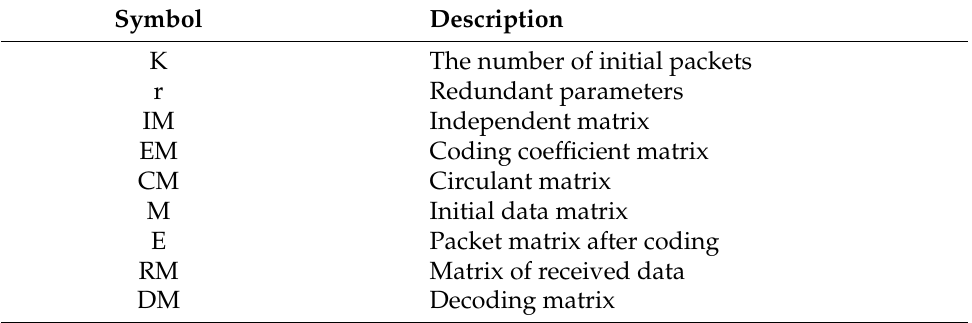
Table 2. Redundant symbol